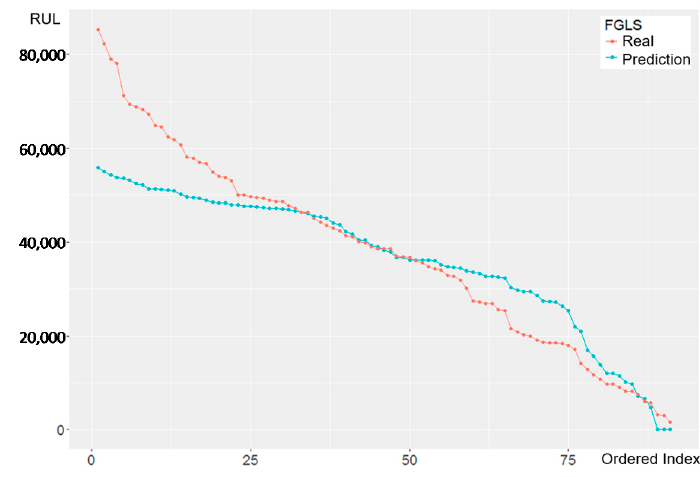
Figure 9. Fitted plot of